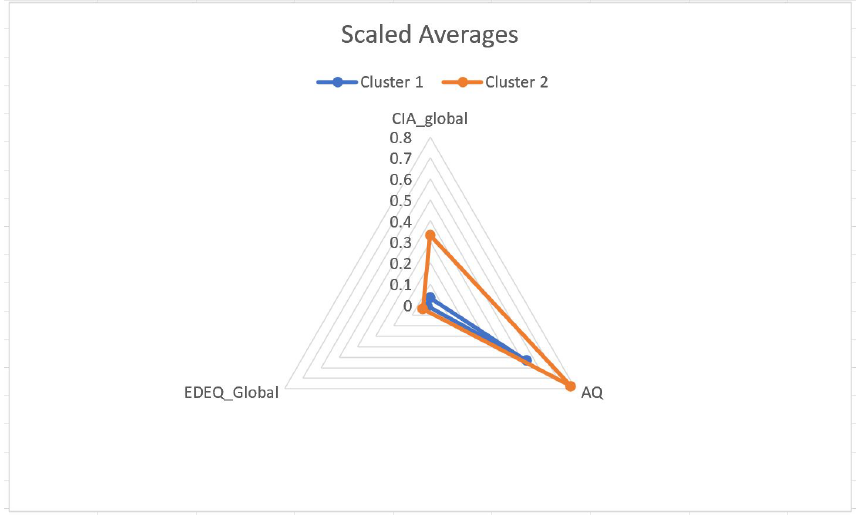
Figure 4. Radar plot of results when the data is scaled from 0 to 1.